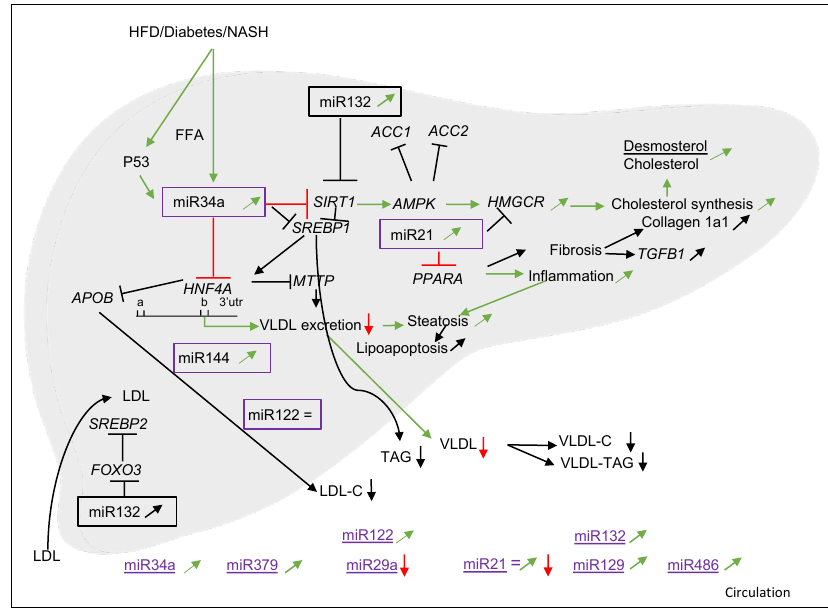
Figure 4. Schematic overview of potential mechanisms in animals (black) of miRNAs involved in cholesterol metabolism. Red arrow is downregulated. Green arrow is upregulated, = is no change. Data are derived as published in the papers selected for this review. HFD—high-fat